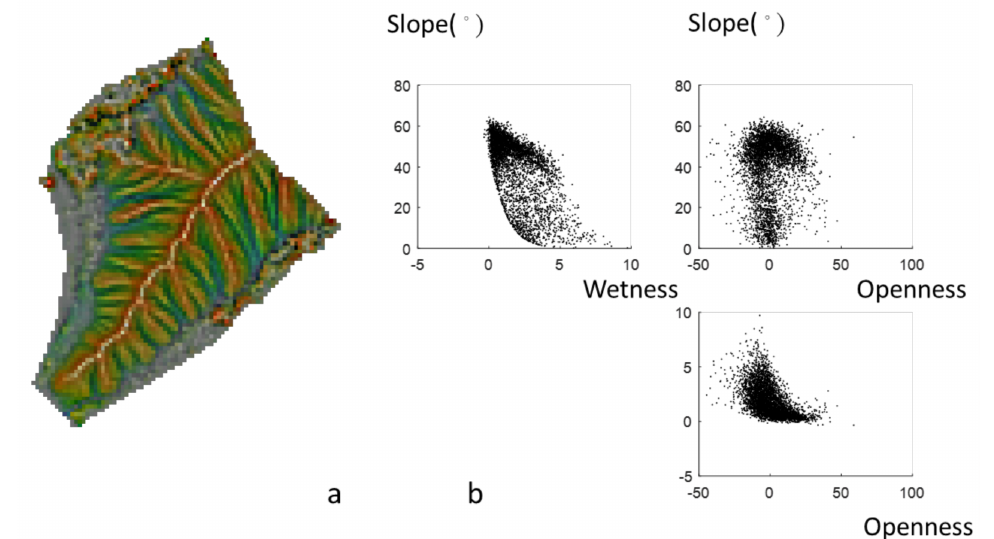
Figure 7. ( a ) 3P relief map and ( b ) scatter plots of aspect, slope, and openness.